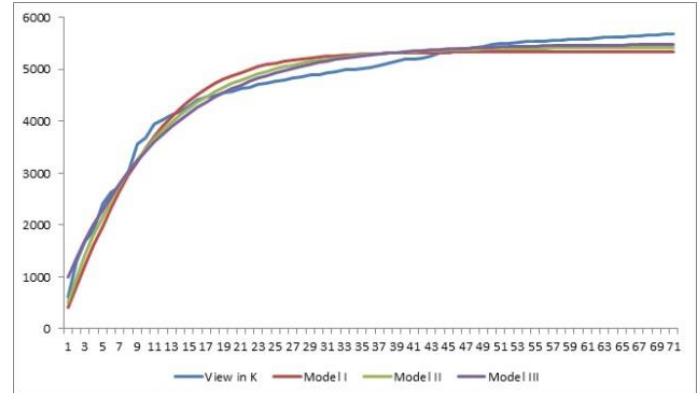
Figure 4. Goodness of fit curve of Dataset 4